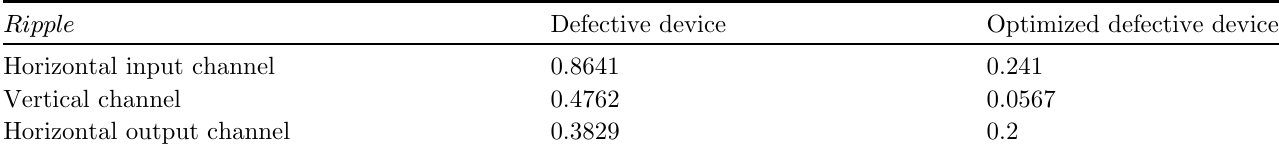
Table 2. Quantitative comparison of Ripple for the double 90 ° bend waveguide